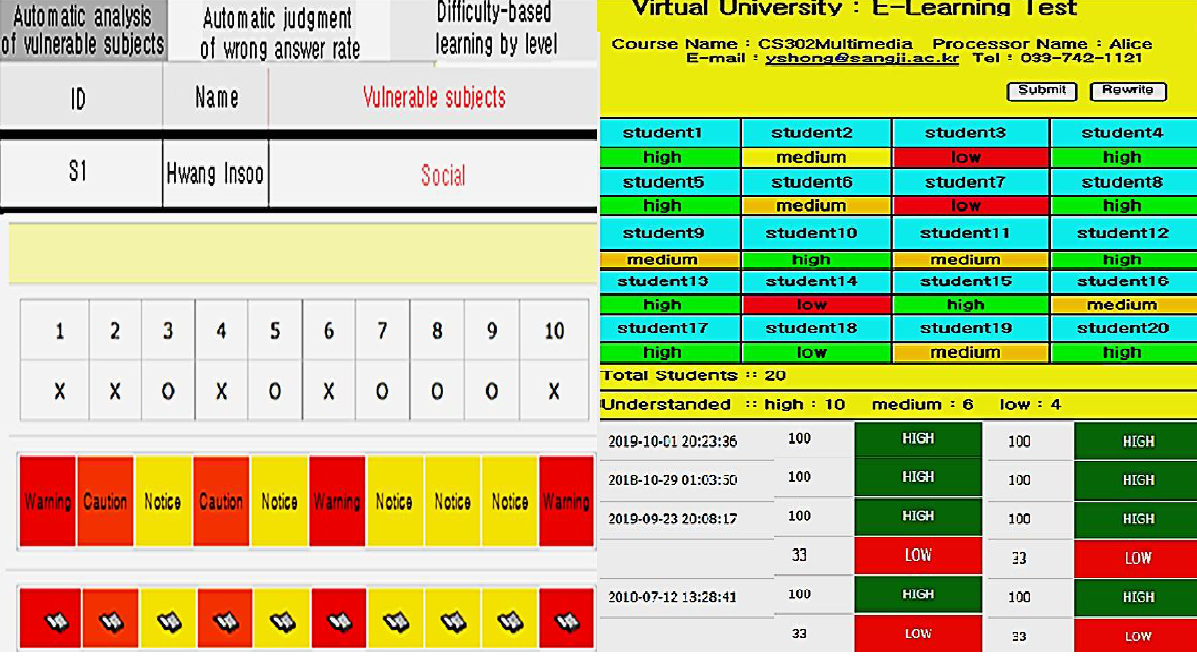
Figure 11. Automatic judgment of wrong answer rate.